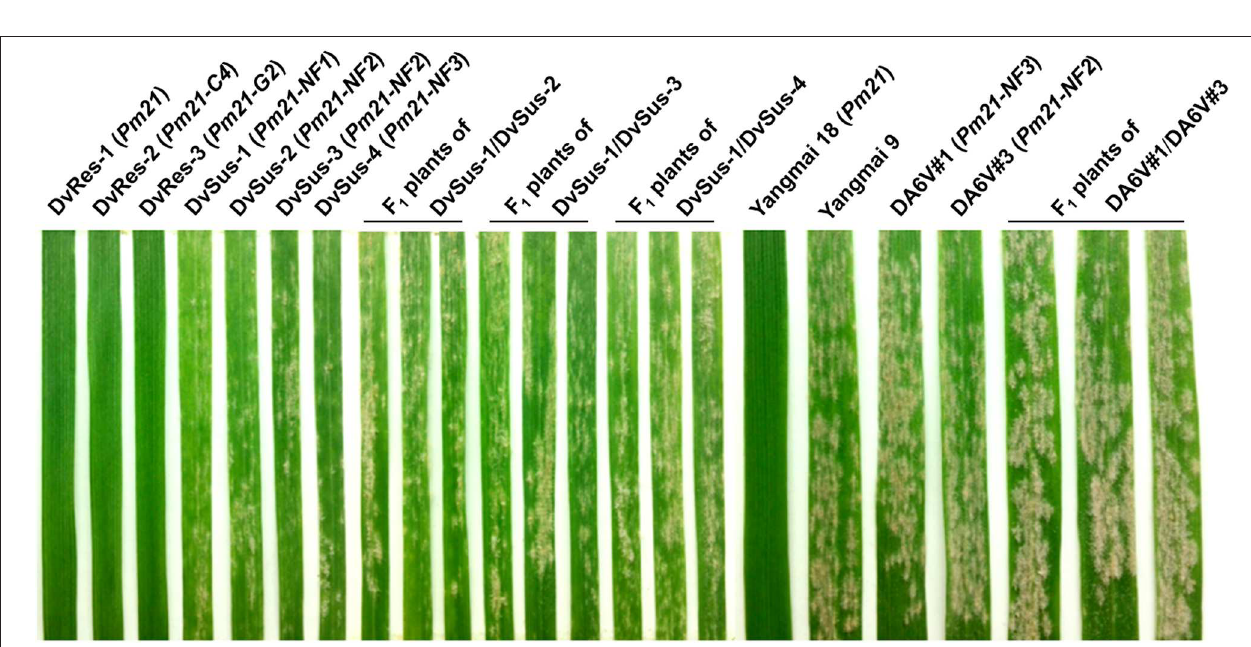
FIGURE 1 | Geographic distribution of the D. villosum accessions used in this study. GRE, Greece. ITA, Italy. TUR, Turkey. BUL, Bulgaria. UKR, Ukraine. MKD, Macedonia. FSU, former Soviet Union. Unknown, the origins of the accessions are unclear.